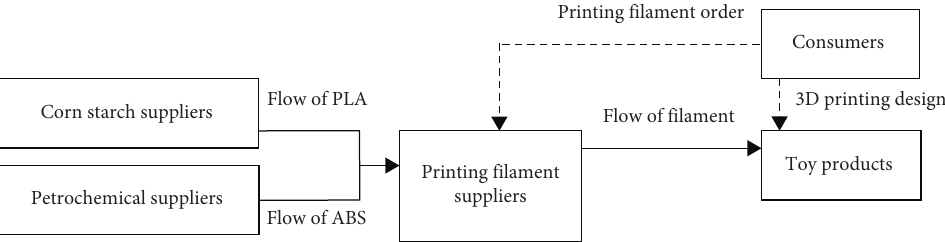
Figure 1: US consumers buy printing filaments to print toys themselves. Data source: authors.